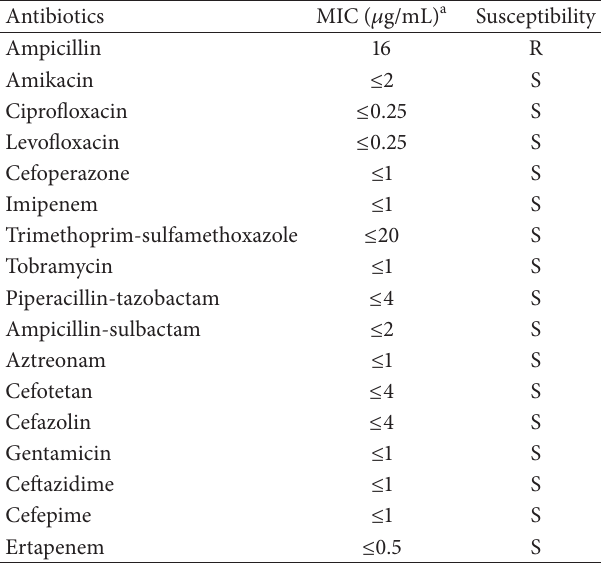
Table 1: Antibiotic resistance profiles of Raoultella terrigena